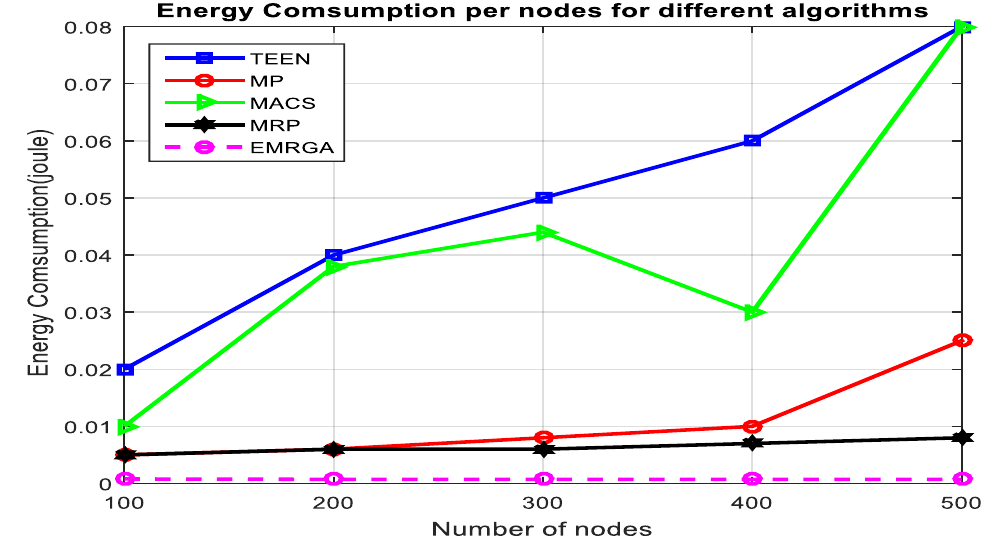
Figure 6. Energy consumption. Figure 6. Energy